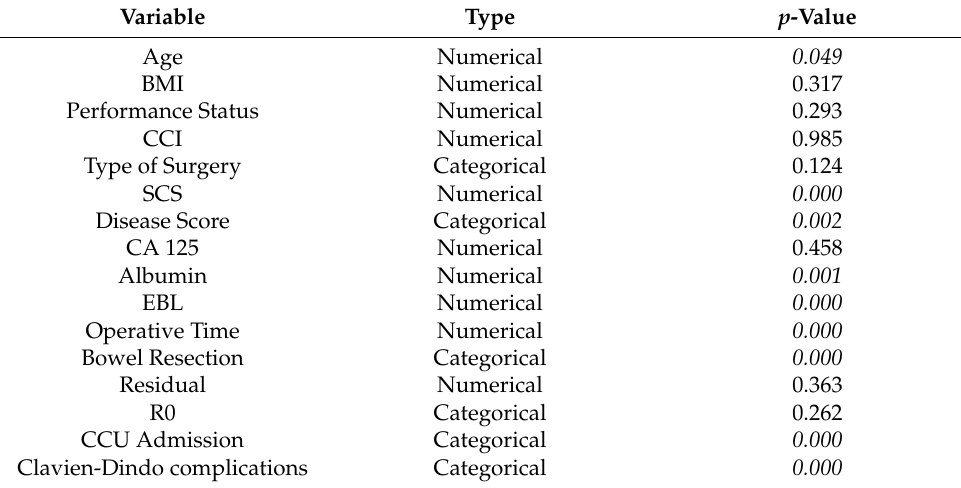
Table 1. Table of all clinical, readily available variables (selected, p -value < 0.05, and unselected, p -value > 0.05) initially interrogated for the LOS prediction. Only variables with p -value < 0.05 were employed in both the calibration and classification process, and finally in the construction of the proposed prediction